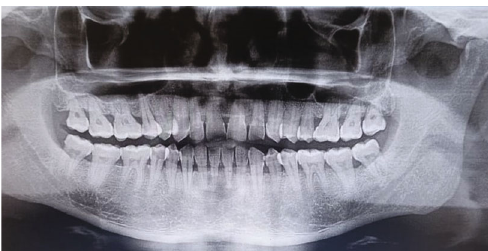
Figure 2: OPG demonstrating an ill-de fi ned periapical pathology with